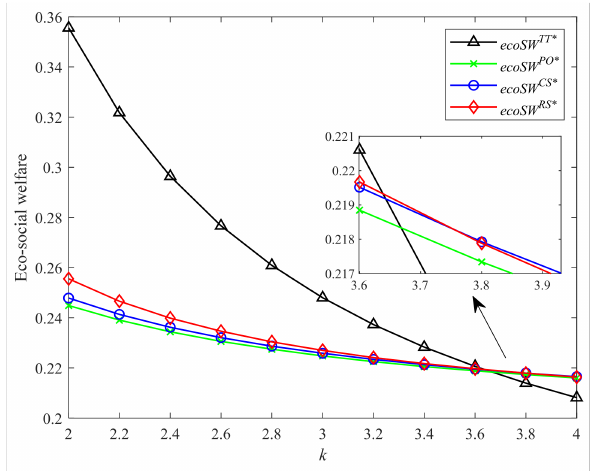
Figure 9. Comparison of eco-social welfare with different k